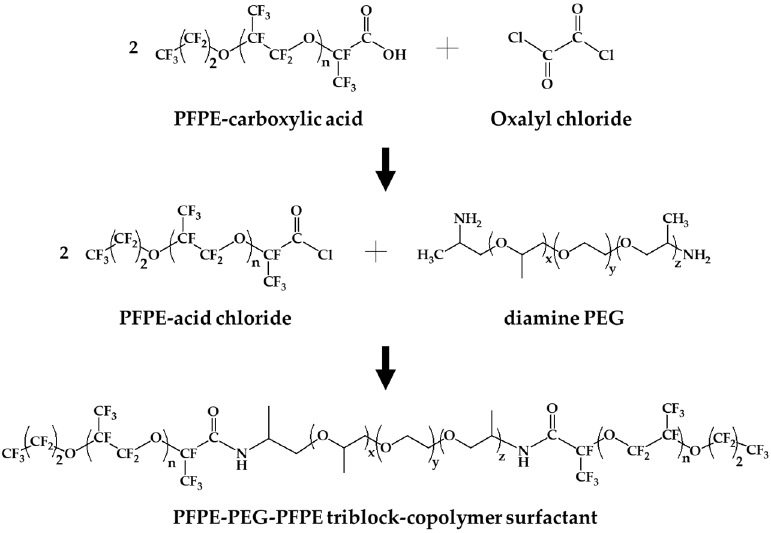
Figure1. Figure 1. Schematic diagram of the synthesis process for PFPE–PEG–PFPE triblock copolymer surfactant.